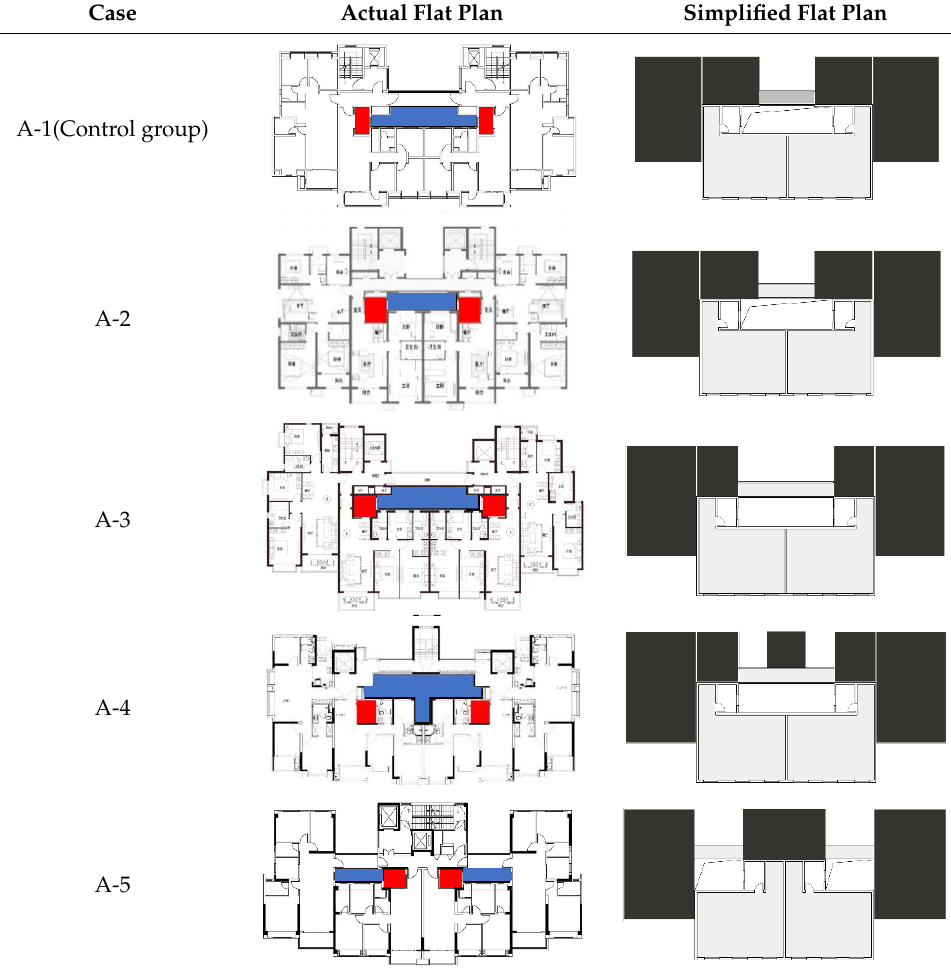
Table 6. Integration of the results of the study of high-rise residences with inner-courtyards.